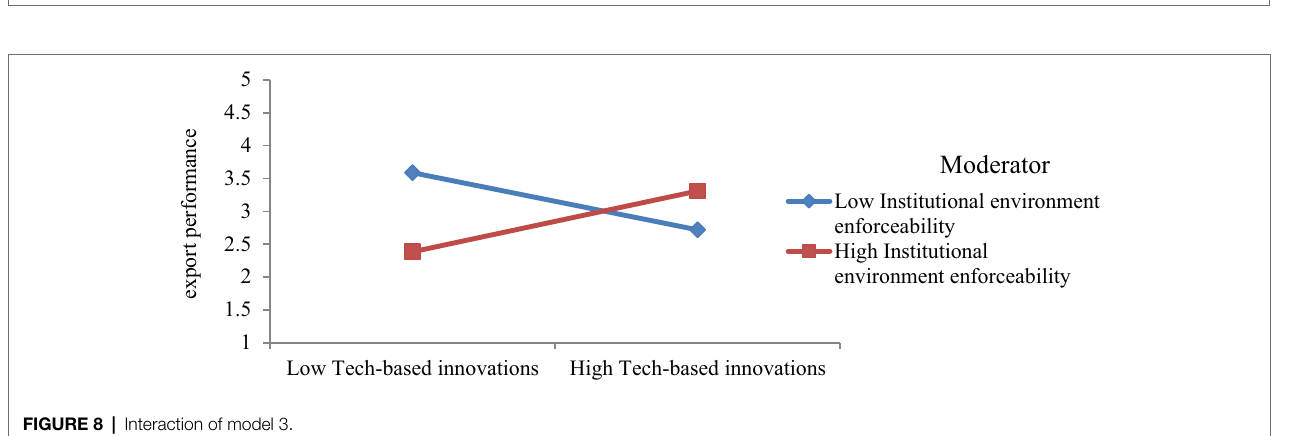
FIGURE 7 | Moderating effect of institutional environment enforceability on technology-based innovations–export performance link. * p < 0.05; ** p < 0.01; *** p <